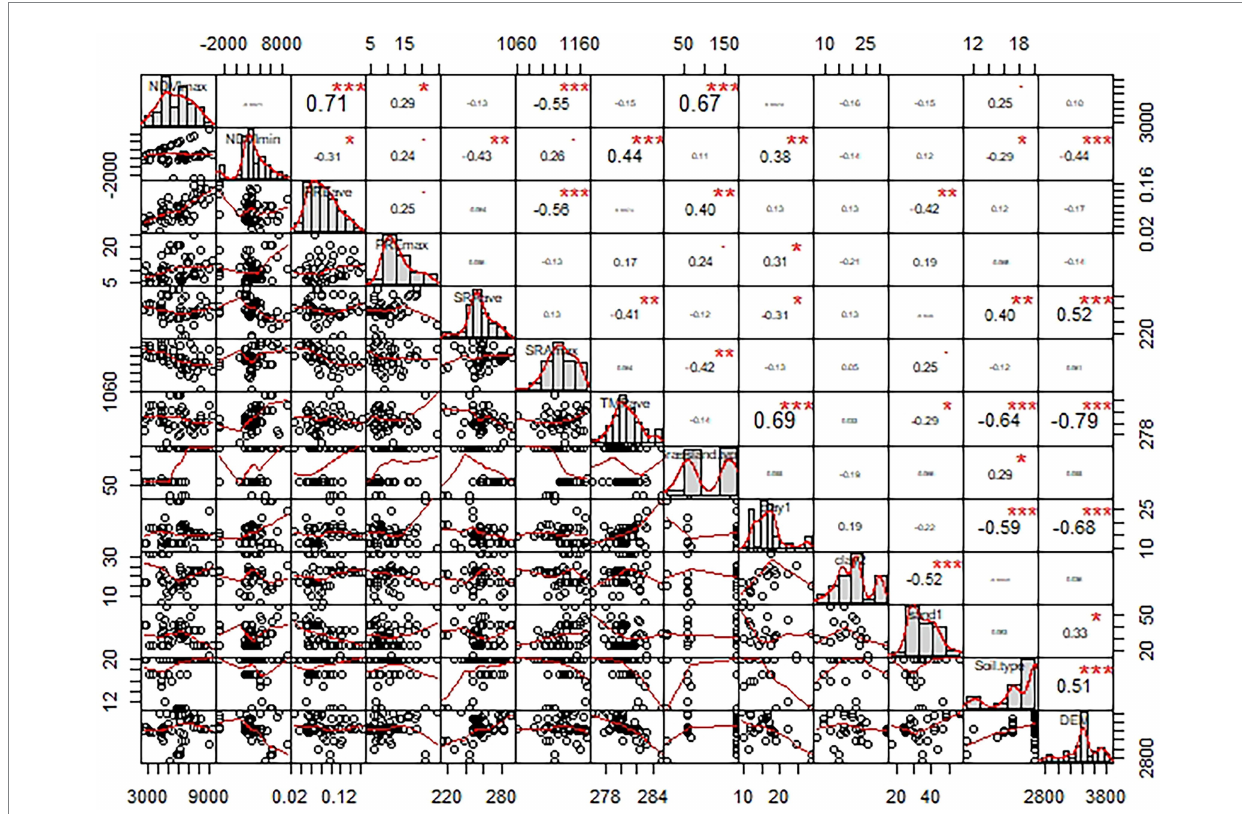
FIGURE 2 The correlation of Pearson coefficient among factors. NDVImax, NDVImin, PREave, PREmax, SARave, SRAmax, TMPave, Clay1, Clay2, Sand1, and DEM refers to the maximum normalized difference vegetation index, the minimum normalized difference vegetation index, the average precipitation, the maximum precipitation, the average solar radiation, the maximum solar radiation, the average temperature, the clay concentration of surface soil, the clay concentration of bottom soil, the sand concentration of surface soil, and digital elevation model, respectively. *denotes p < 0.05, **denotes p < 0.01; ***denotes p <